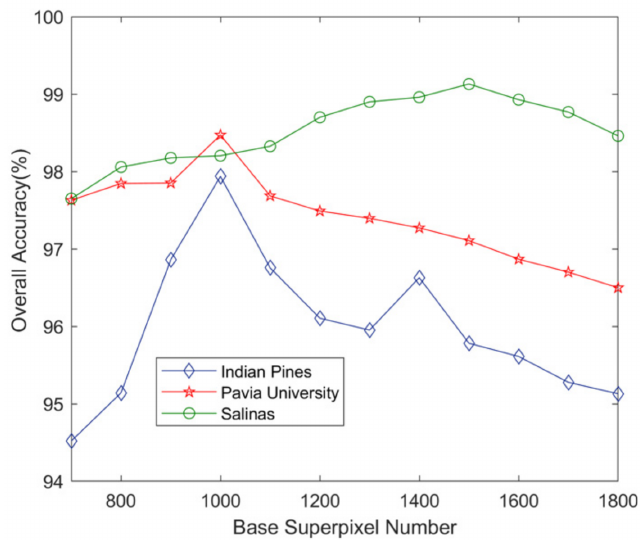
Figure 6. Variation of classification results with different superpixel numbers on three